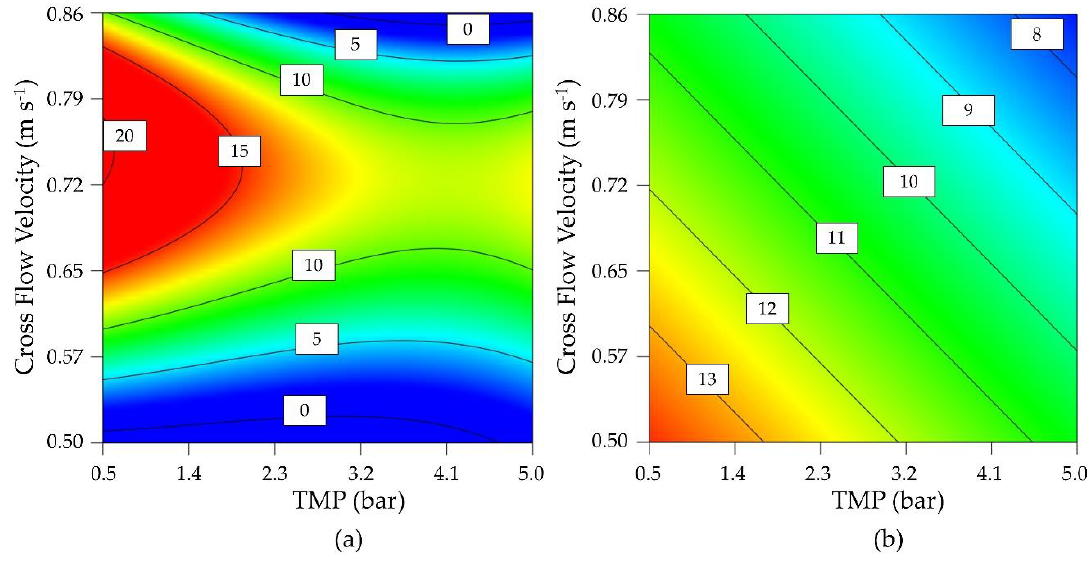
Figure 3. Contour plot of a D-optimal design for the optimization of ( a ) permeate flux (L m − 2 h − 1 ) and ( b ) enzyme activity (U mL − 1 ).